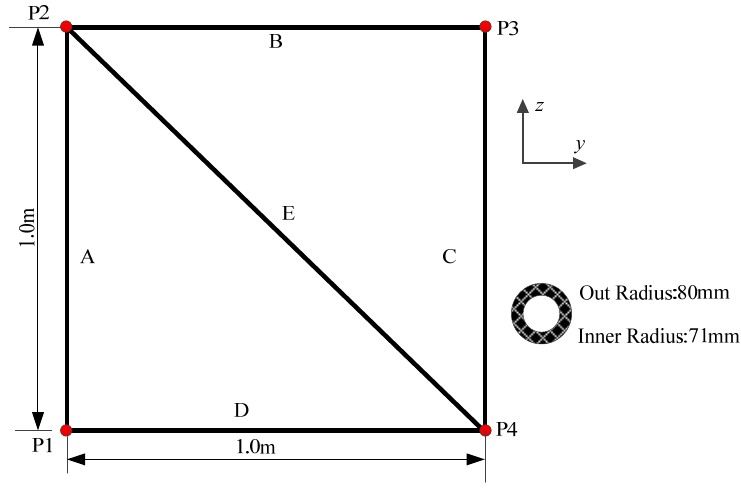
Figure 2. Two-dimensional frame structure.